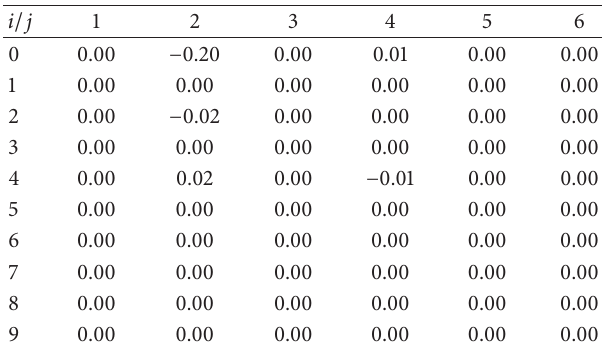
= 190 , stable, aL Figure 5: Simulation 9 × 7 . 𝑅 𝑡 = 5 = 165 grid 9 × 7. aL